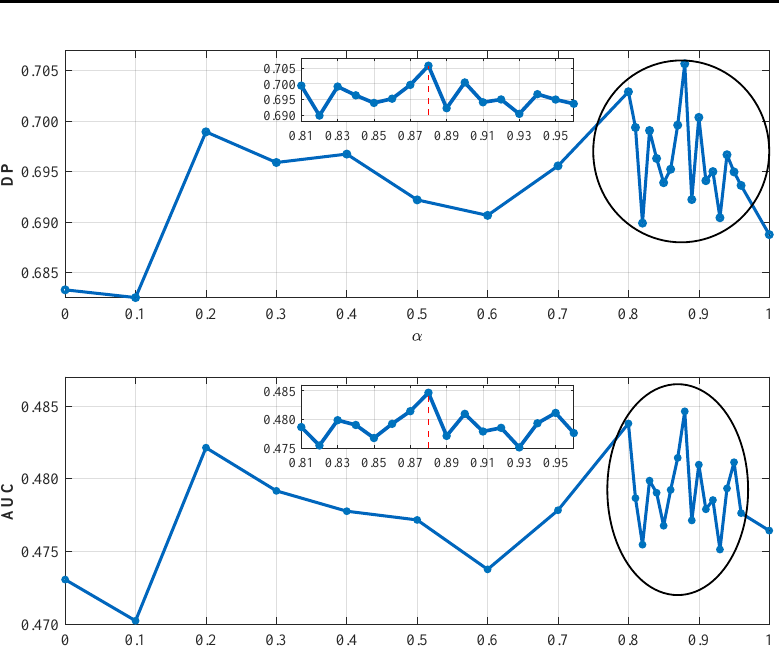
Figure 8. Average performance on three benchmarks when the smooth index α varies from 0 to 1. Top : the curve of AUC score. Bottom : the curve of DP